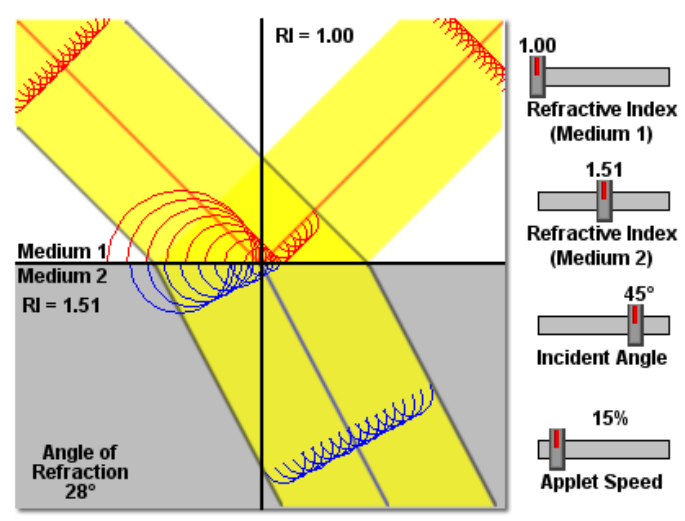
Figure 4. Screenshot from applet No. 4, ‘Reflection and refraction with Huygens wavelets’, during running, with secondary waves at the change of medium